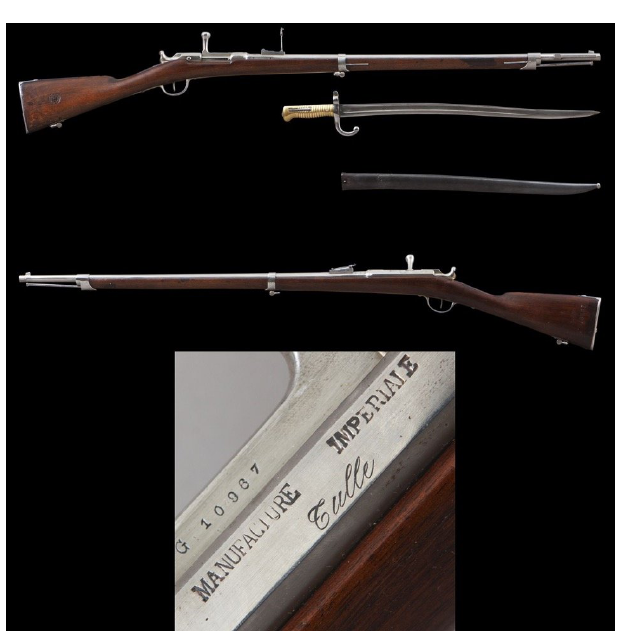
Fig. 7 . Photo of the “Chassepot” regulatory breech loading rifle (1866 model) used by the French infantry. Source: